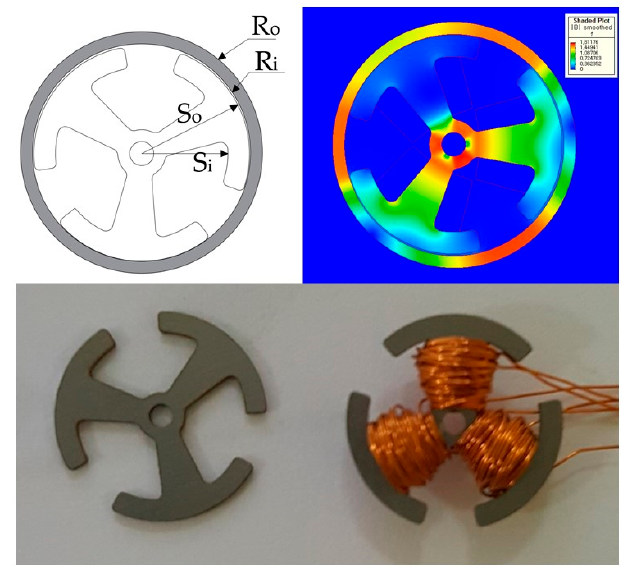
Figure 9. Core with new material: Optimized three-poles core.